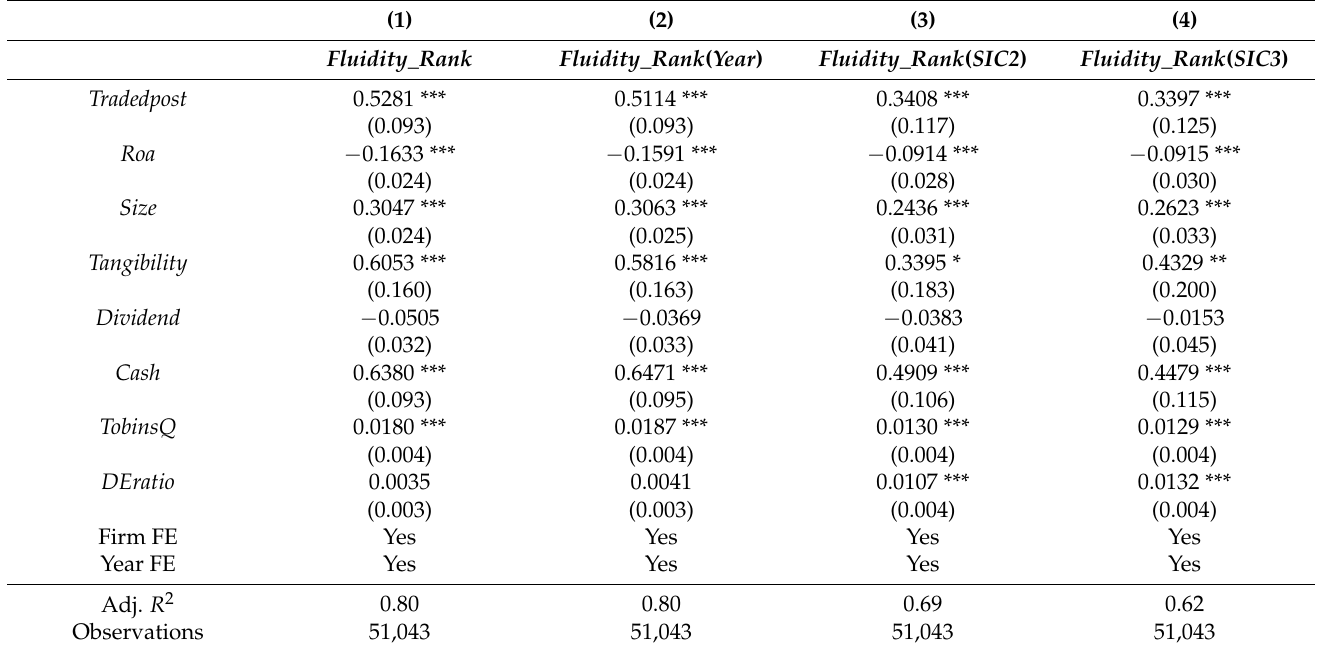
Table A3. CDS initiations and fluidity ranks. This table reports the results of regression model (1) for alternative versions of Fluidity measures, which were ranked by deciles from each year and by industry classifications. Standard errors were clustered by firms and reported in parentheses. Lagged firm-specific controls and the firm and year fixed effects are included in all specifications. Coefficients with *, **, or *** indicate a significance level of 0.10, 0.05, or 0.01, respectively. For detailed definitions of variables, please refer to Appendix A Table